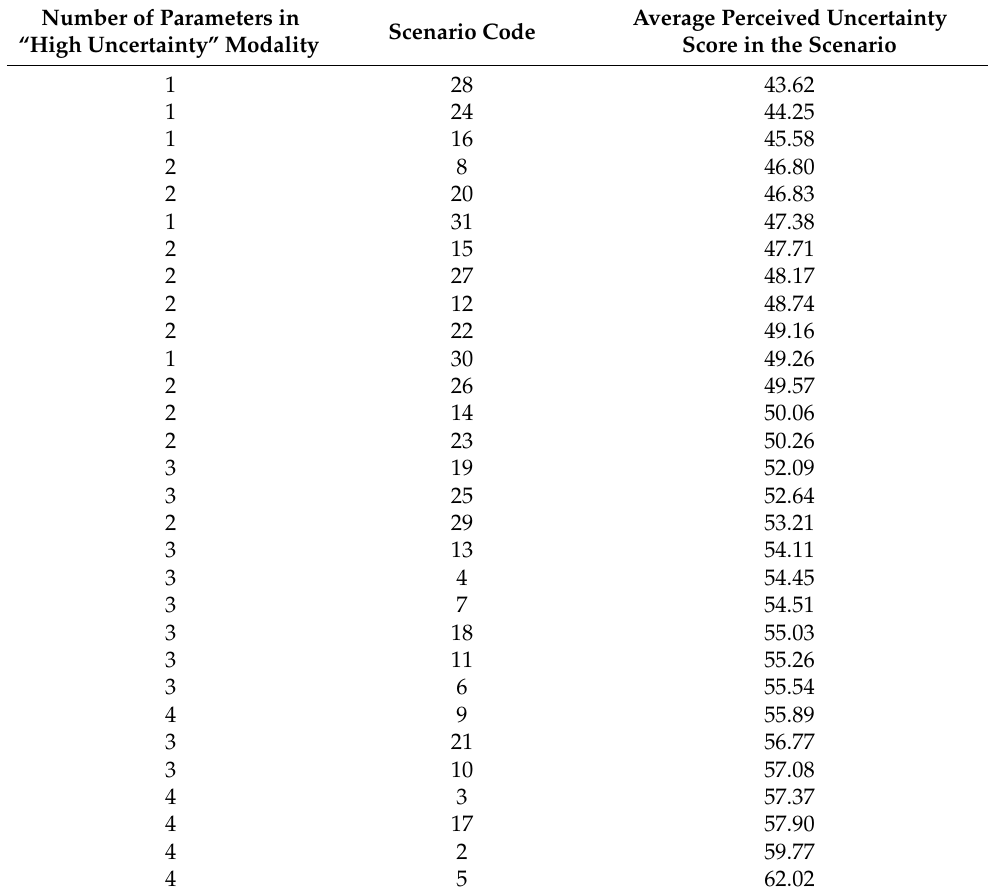
Table 4. Average perceived uncertainty score in the scenario-by-scenario code and the number of parameters in the “High uncertainty”